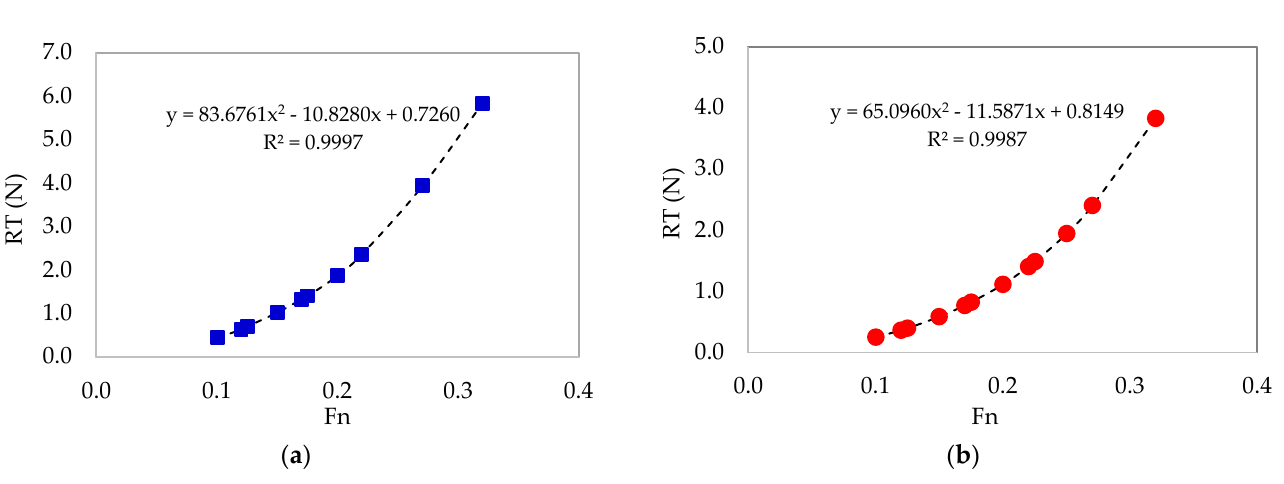
Figure 15. Validation of CFD with experiments of amphibious vehicles; ( a ) w/caterpillars, ( b ) w/o caterpillars.